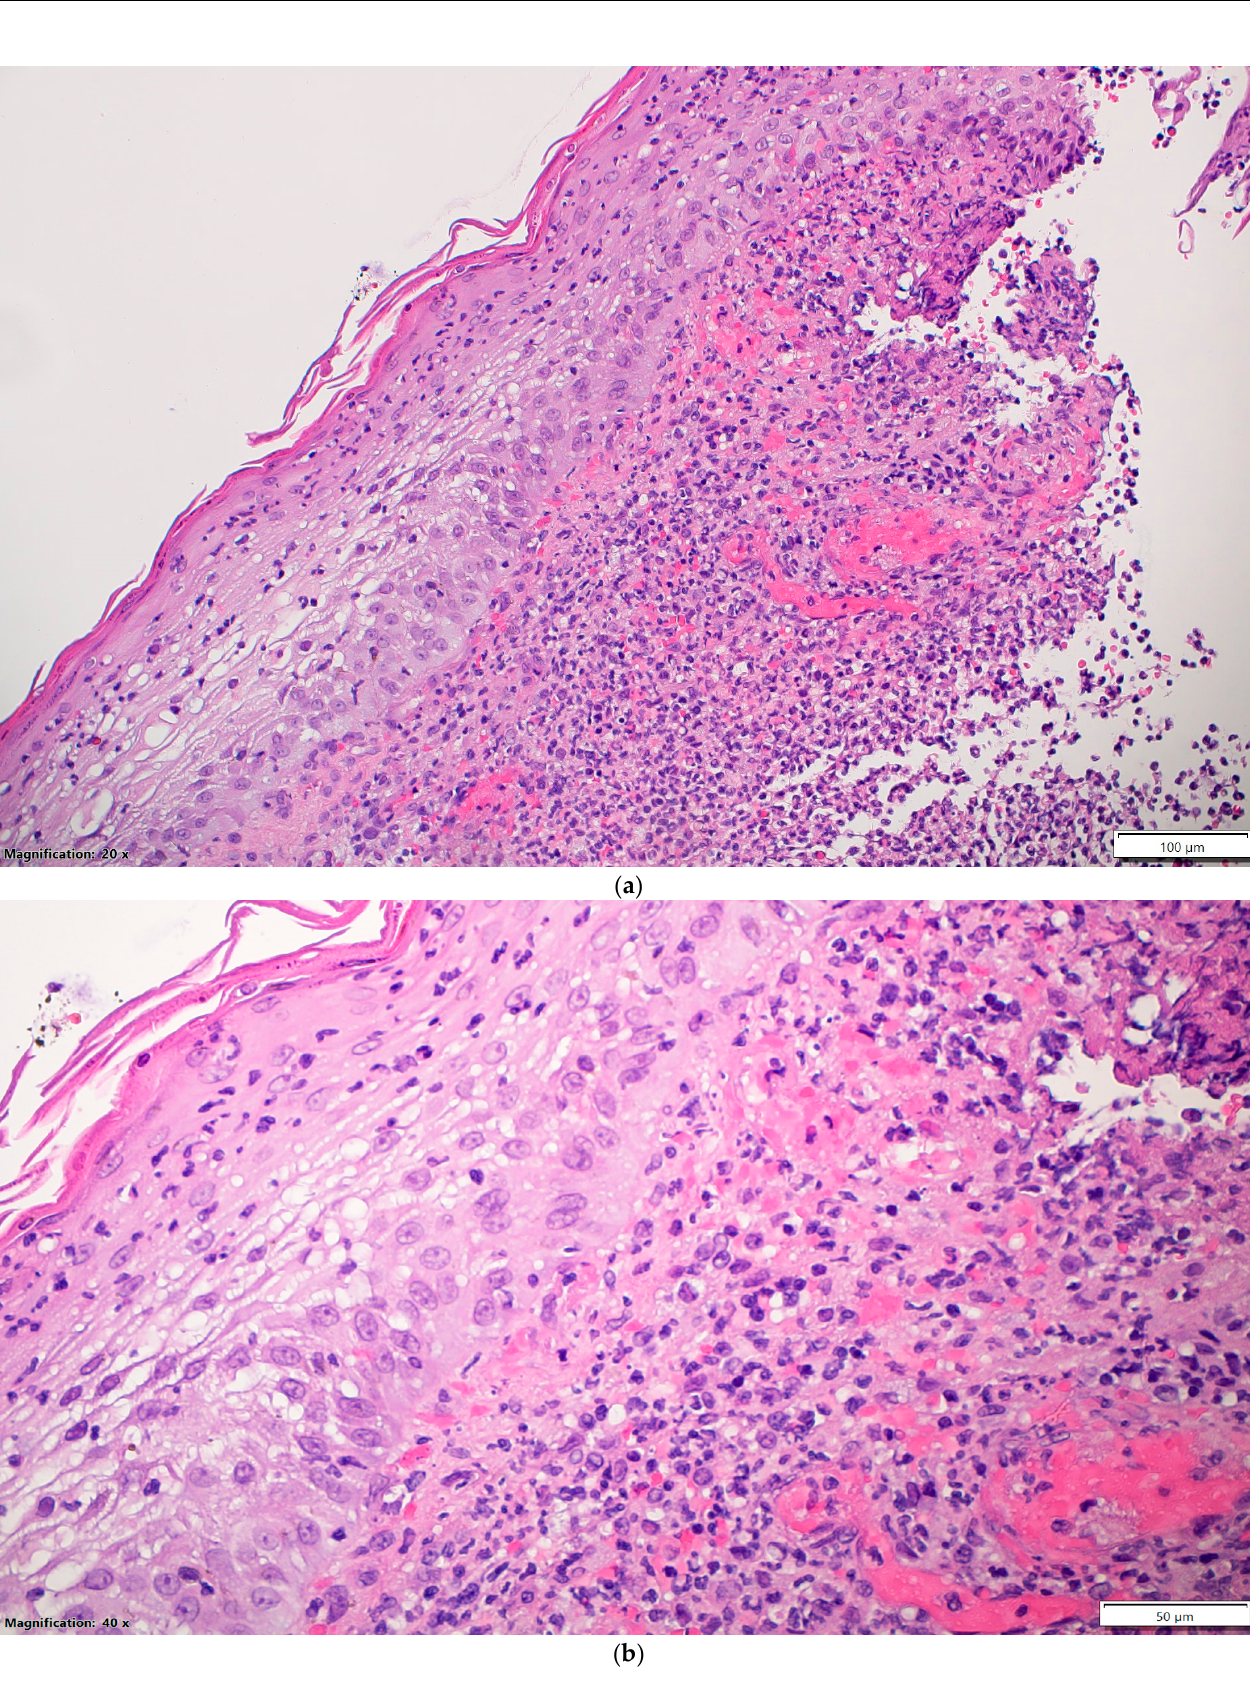
Figure 3. Epidermal neutrophil infiltration and underlying abscess formation and hemorrhagic